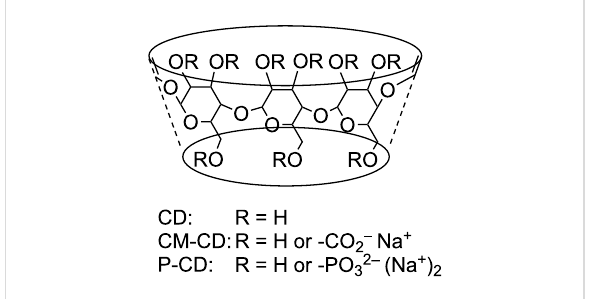
Figure 1: Structure of cyclodextrins (CD) and their carboxymethylated (CM-CD) and phosphated (P-CD) derivatives.